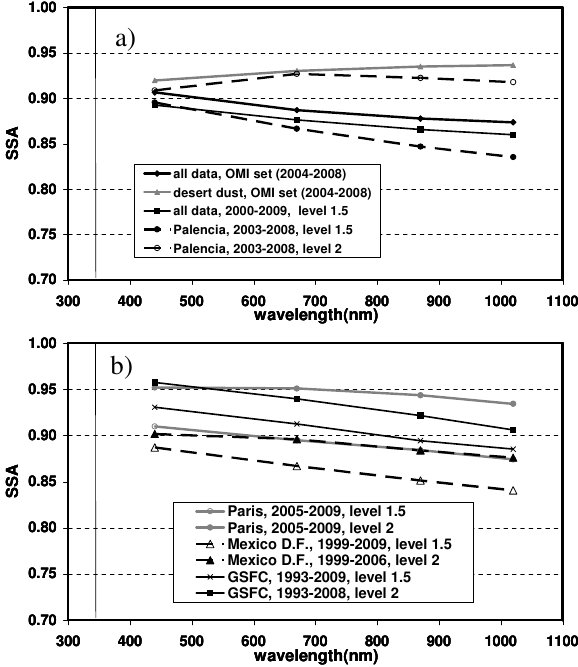
Fig. 8. (a) Mean values of the spectral SSA for level 1.5 of El Arenosillo for the periods 2004–2008 (used with OMI data) and 2000–2009; SSA for desert dust only for the period 2004–2008 and those of Palencia station as indicated. (b) The same for three rep- resentative cities (Paris, Mexico D.F. and GSFC at Greenbelt near Washington-DC) and their corresponding periods of data for level 1.5 and